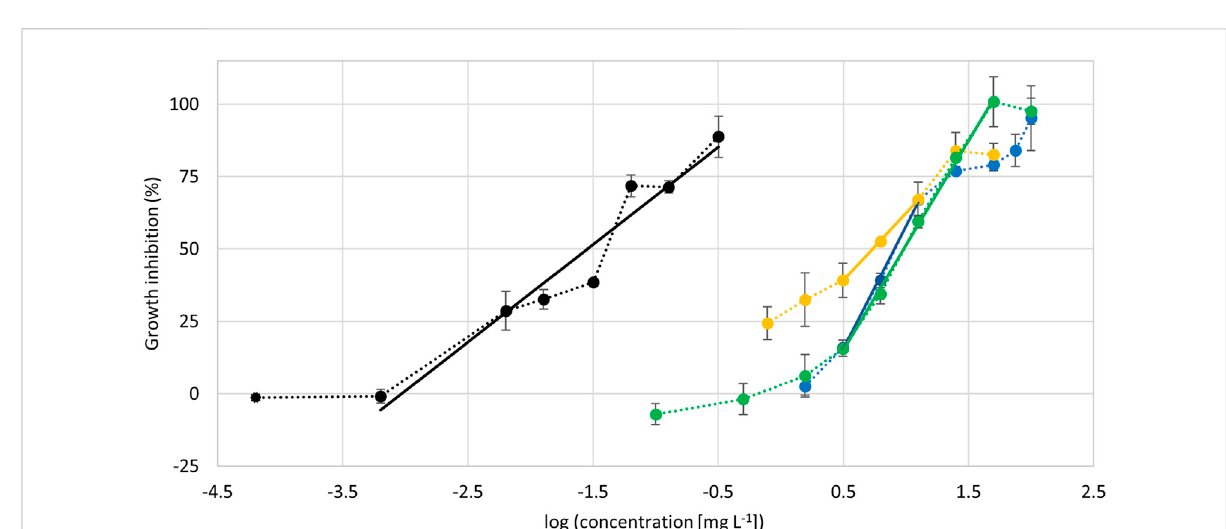
FIGURE 5 Dose-response curves showing the algae growth inhibition in dependency of test substance concentration. Black: treatment with ethanolic extract, concentration corresponds to the additive concentration of mangiferin and hyperoside contained in the extract. Yellow: treatment with mangiferin. Blue: treatment with hyperoside. Green: treatment with 1:1 mixture (w:w) of mangiferin and hyperoside. n = 4. Lines represent linear regressions used to determine EC 50 -values. Dotted lines represent a visual guide.